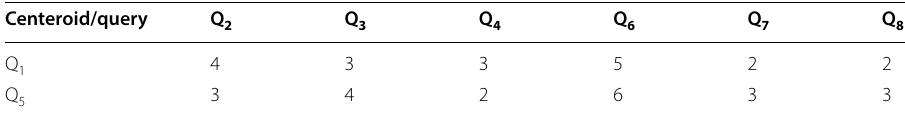
Table 6 First loop Centeroid/query